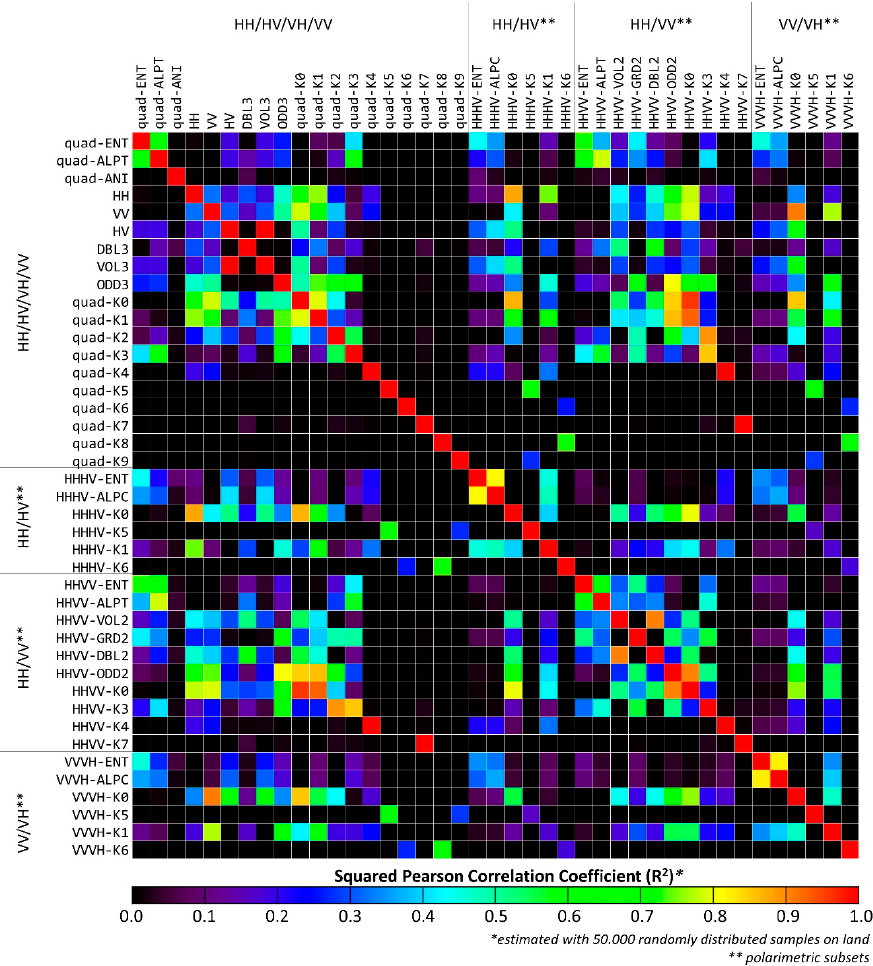
Figure 3. Correlation-Matrix of quad- and dual-polarimetric C-Band Radarsat-2 features showing the squared Linear Pearson Correlation Coefficient ( R 2 ) ranging from 0.0 (no correlation) to 1.0 (full linear correlation, determination respectively). R 2 was estimated using 50,000 randomly distributed samples on land (roughly 10% of all land pixels). Note that dual-polarimetric data of Radarsat-2 were derived as polarimetric subsets and thus are not affected by temporal variations. Feature abbreviations are as follows (see Table 2): ENT (Entropy), ALPT (polarimetric Alpha scattering angle of Coherency Matrix), ALPC (polarimetric Alpha scattering angle of Covariance Matrix), HH/VV/VH (PolSAR Channels), DBL3 (double bounce of the Yamaguchi et al. Decomposition [27]), VOL3 (volume scattering of